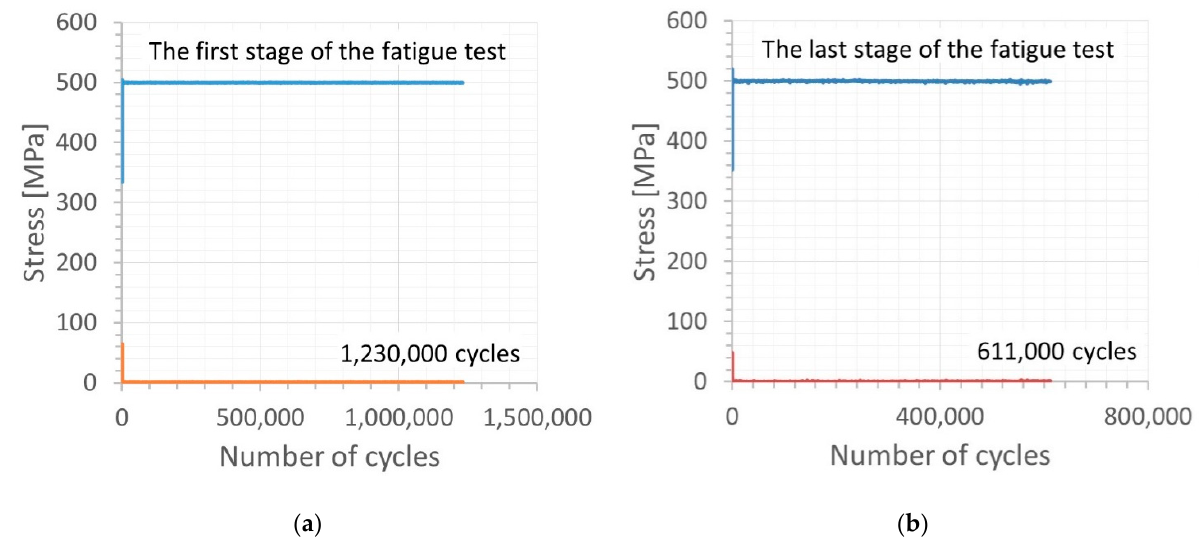
Figure 8. Maximum and minimum values of stress signal for the cycles: ( a ) and ( b ) up to 1,230,000, and 1,841,000 (sum before the material fracture = 1,841,757 cycles), respectively.